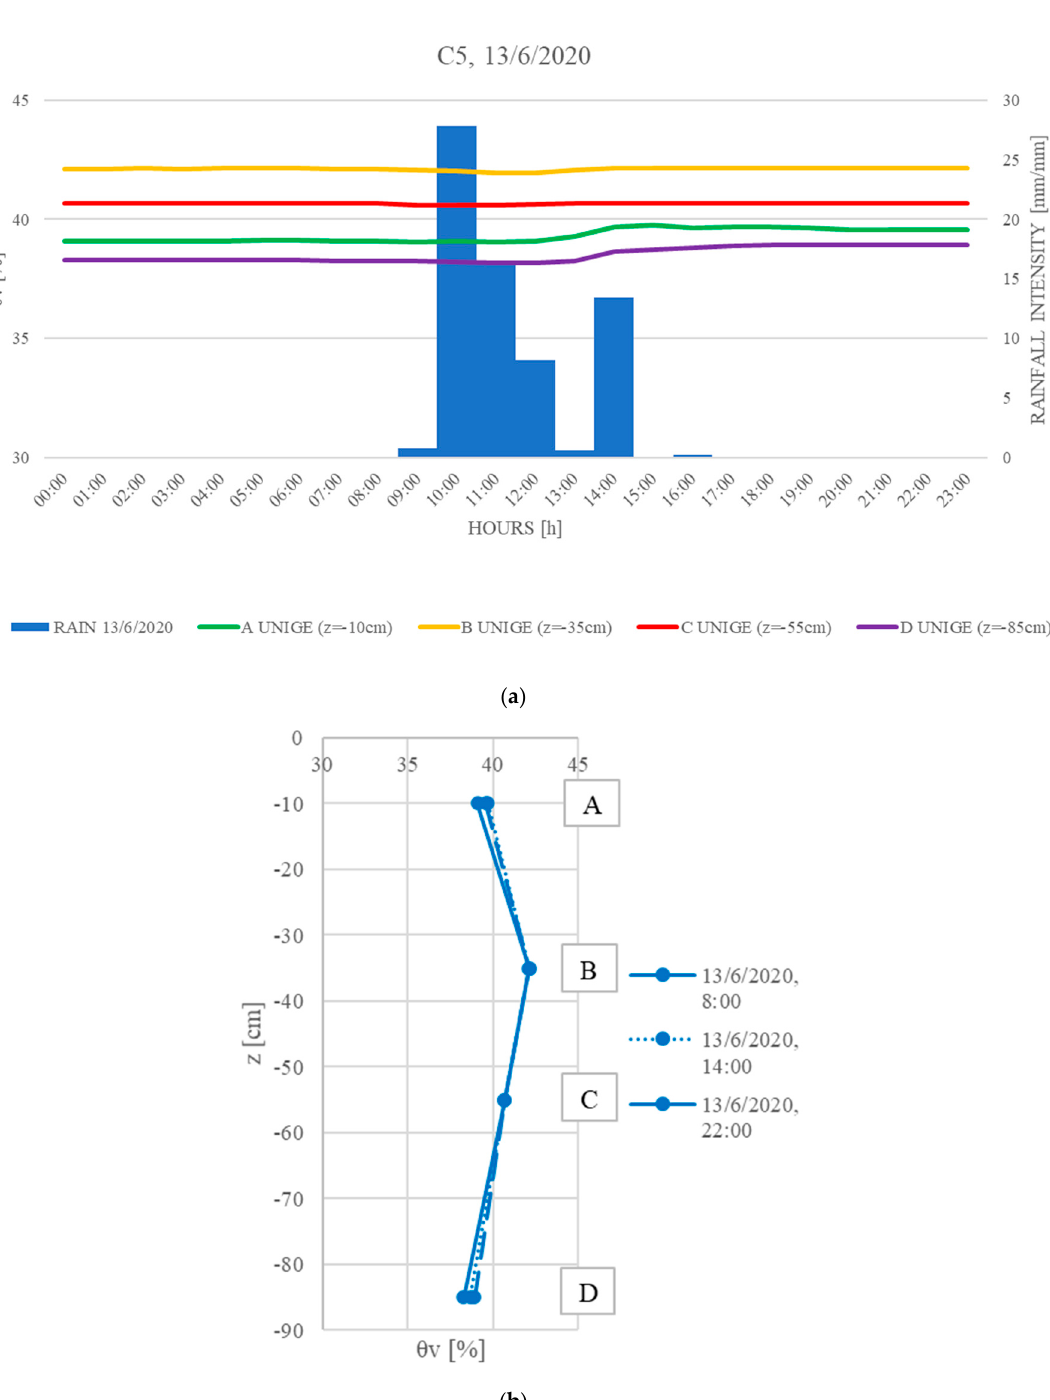
Figure 22. ( a ) 13 June 2020 rainfall event and soil water contents; ( b ) Vertical soil moisture profiles of June 2020 rainfall event.